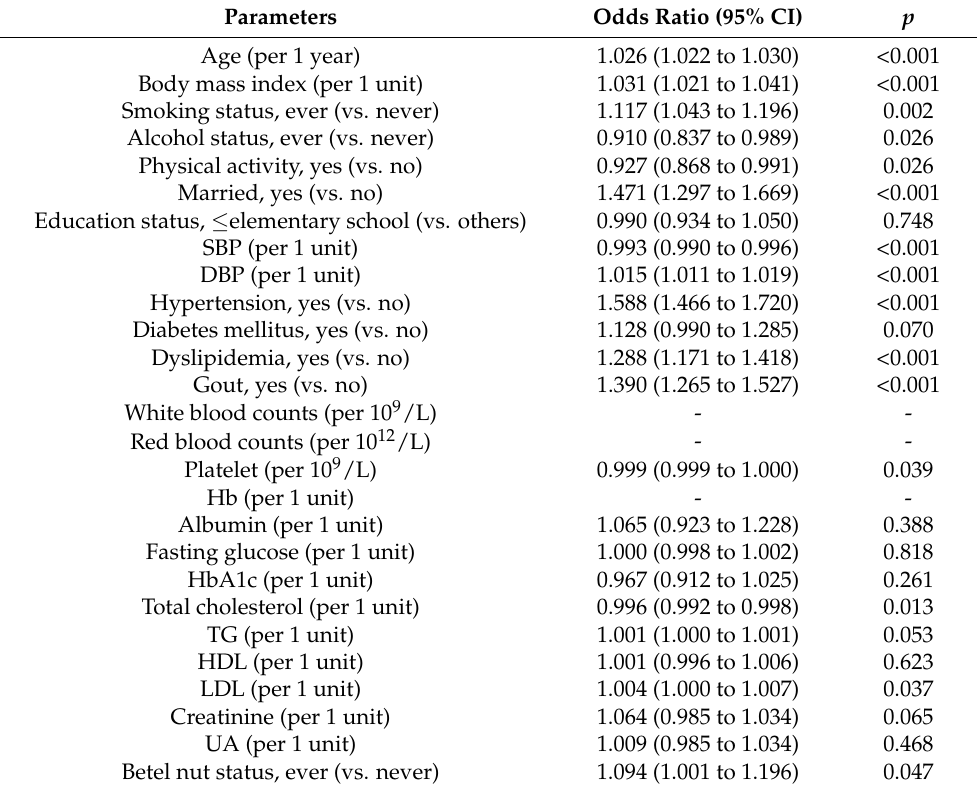
Abbreviations: as Table 1 and CI: confidence interval. Adjusting for age, smoking status, alcohol status, physical activity, marital status, educational status, body mass index, SBP, DBP, history of hypertension, history of dyslipidemia, history of diabetes mellitus, history of gout, platelet count, HbA1c, serum fasting glucose, total cholesterol, TG, LDL, HDL, serum albumin, creatinine, and